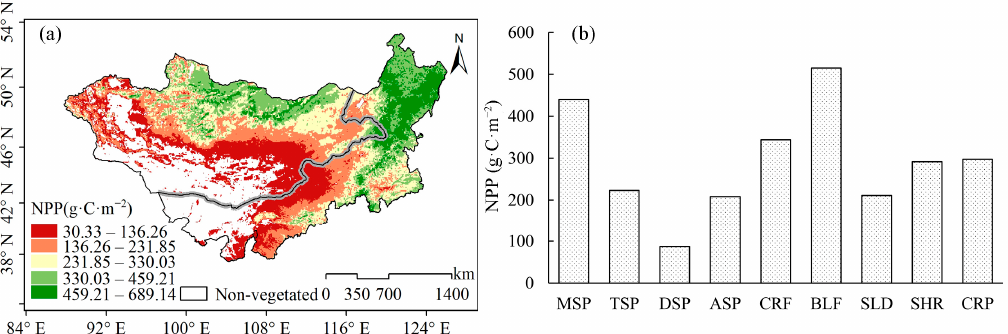
Figure 4. Spatial distribution ( a ) and the average value of different vegetation types ( b ) of NPP during the growing seasons from 2000 to 2019 in the MP.